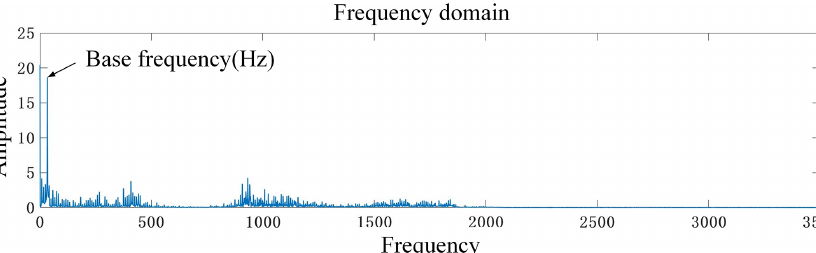
Figure 6. FFT of the cutting force signal under working condition a .